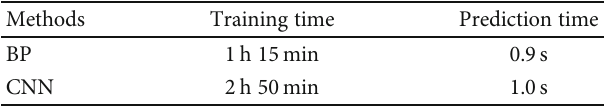
Table 6: Comparison for computational time between CNN and BP neural networks.